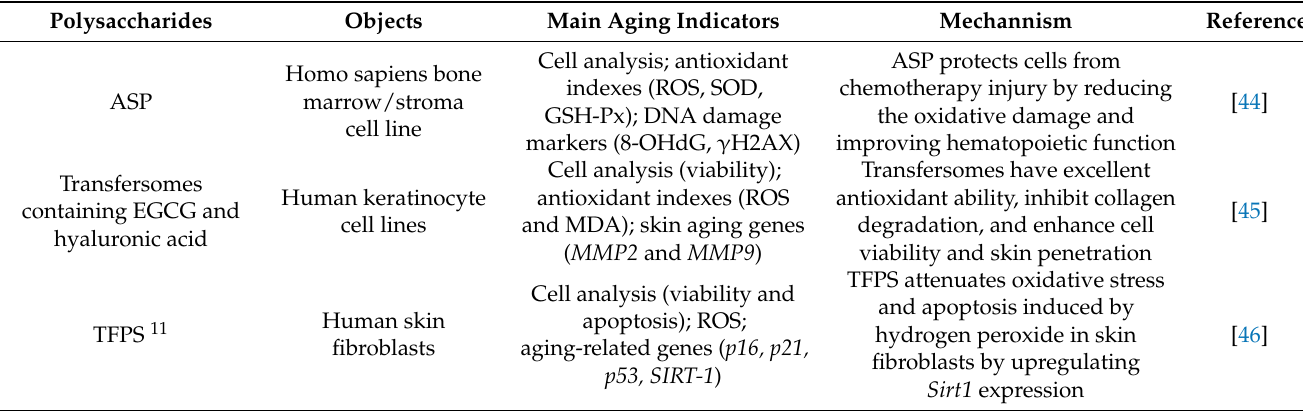
Table 4. Anti-aging study of polysaccharides in human cell